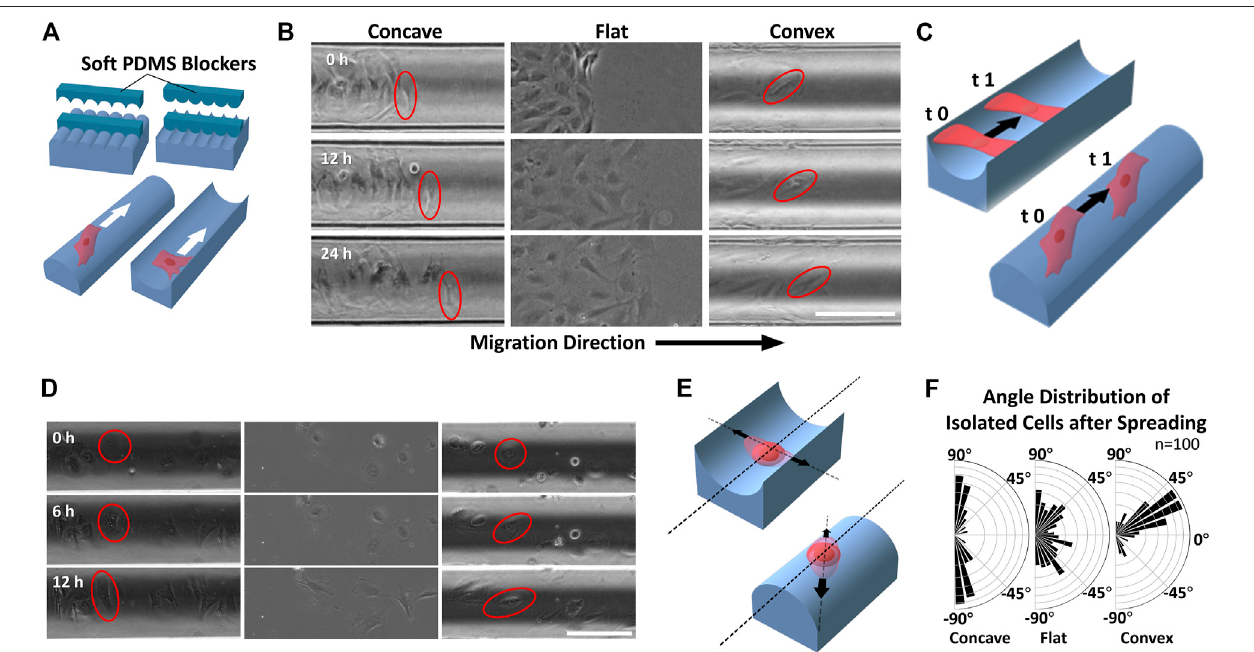
FIGURE 3 | Migration of ASMCs on curved surfaces (A) A wound model experiment to provide cell-free gaps with well-de fi ned geometry in the collective cells by placing and removing soft PDMS blockers (B) Representative time-lapse images of longitudinal migration (along the cylinder axis) on different surfaces during 24 h. The red oval frames show the alignment of the leading cells during movement (C) Schematic illustration of the two migration modes of ASMCs on concave and convex surfaces (D) Representative time-lapse images of scattered single ASMCs spreading on different surfaces during 12 h. The red circle/oval frames mark the changing shape of the cell during spreading (E) Schematic illustration of the ASMCs spreading along with certain directions on curved surfaces (F) Polar plots showing the quantitative data of biased angle distribution of isolated ASMCs after 12 h of spreading on curved surfaces ( R (cid:1) 100 μ m), and a fl at surface (n (cid:1) 100). Scale bar (cid:1) 200 μ